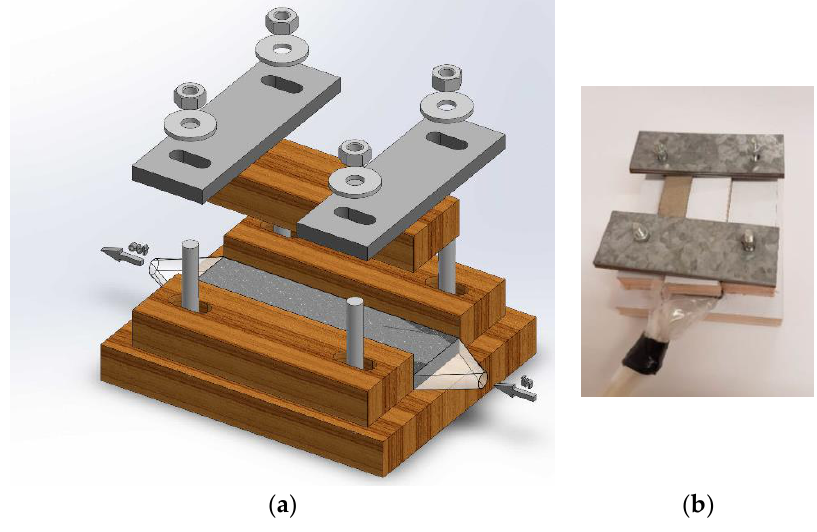
Figure 2. ( a ) 3D drawing and ( b ) a view of experimental cell for hydraulic permeability measurements.